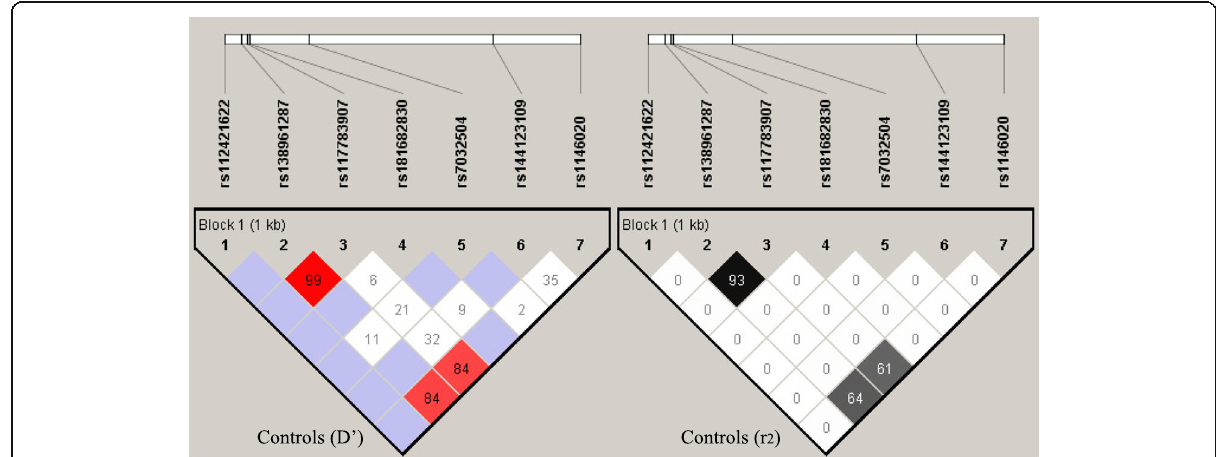
Fig. 2 Linkage disequilibrium diagram of seven SNP loci in the GRIN1 gene. Left is D ’ in the control group, and the red grid represents D ’ = 1. Right is r 2 in the control group, and the black grid represents r 2 =